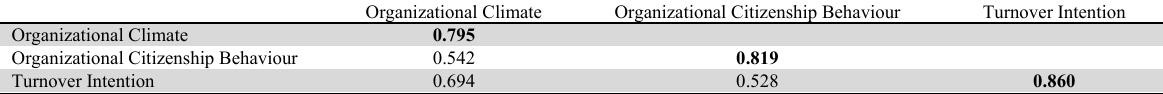
Discriminant validity